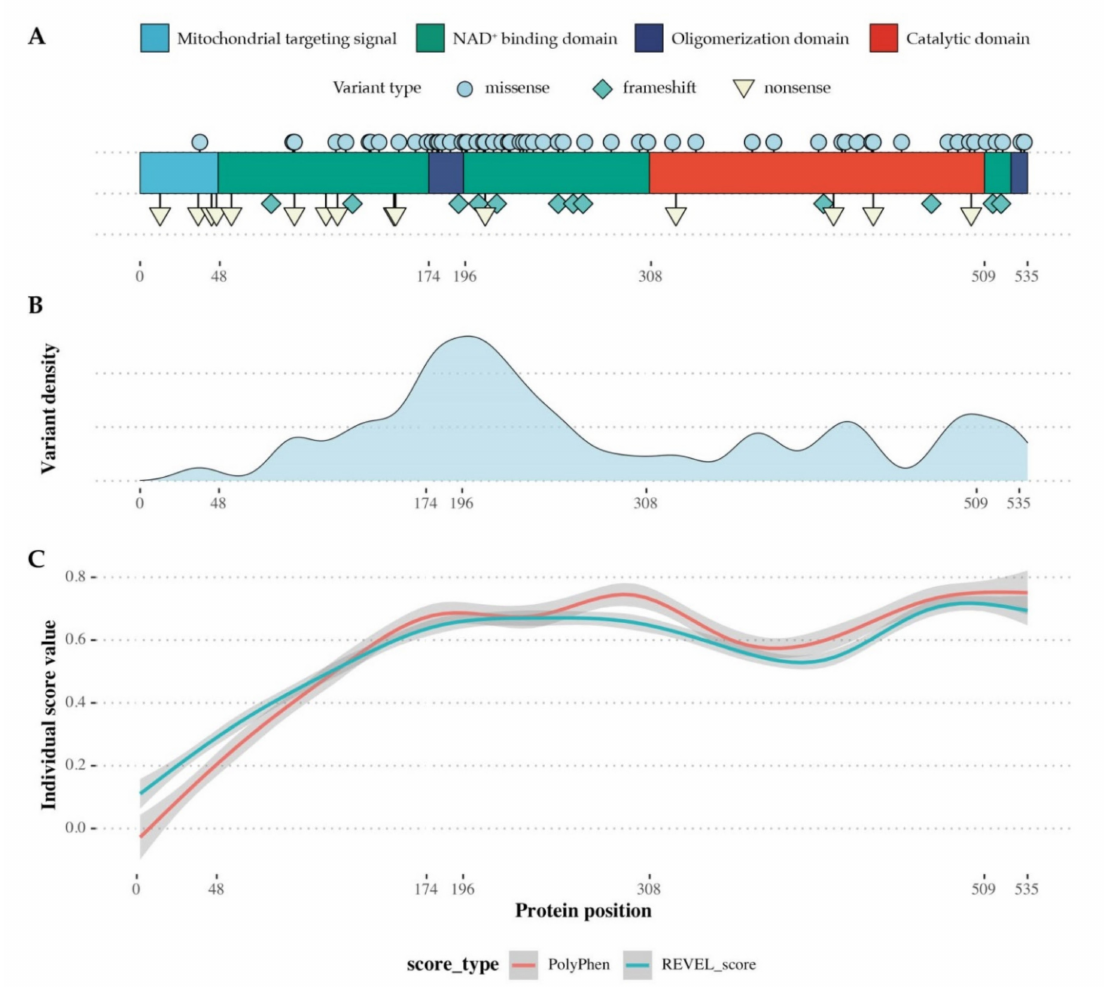
Figure 4. Distribution of disease-causing variants along a linearized model of the SSADH protein. ( A ) Linearized model of the SSADH protein. Functionally important domains are highlighted; symbol-coded variant distribution. ( B ) Assessment of variant density reveals a distinct cluster of pathogenic missense variants in the central region of the SSADH protein and mainly involves the NAD + binding domain and the oligomerization domain. ( C ) Polynomial regression model of two pathogenicity scores (PolyPhen and REVEL) for all possible missense variants along the linearized SSADH